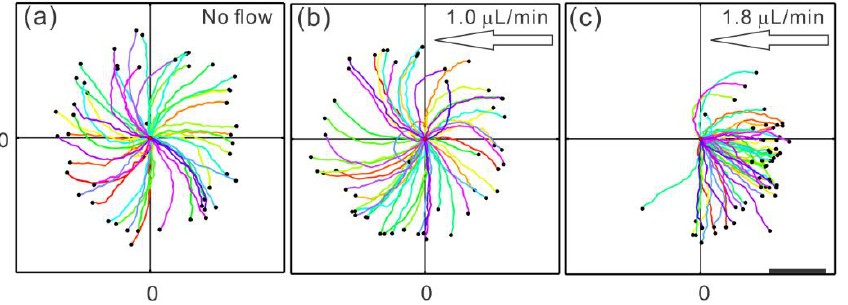
Figure 5. Bull sperm response to fluid flow. The coordinate (0,0) marks the starting point of all of the tracks, which were followed for 2.8 s. ( a ) When there is no flow, sperm exhibit curved trajectories as a segment of their near-circular tracks. ( b ) When the flow rate is below the threshold for upstream swimming (which was measured as 1.1 µL/min), sperm trajectories drift downstream, i.e., the trajectories to the left are extended further and curved less than the ones to the right. ( c ) Once the flow rate is above the onset, sperm exhibit nearly linear trajectories with an upstream component. (a) and (c) adapted from Ref. [57]. Copyright 2015 American Physical Society. (b) adapted from Ref. [53]. Copyright 2015 by the authors.